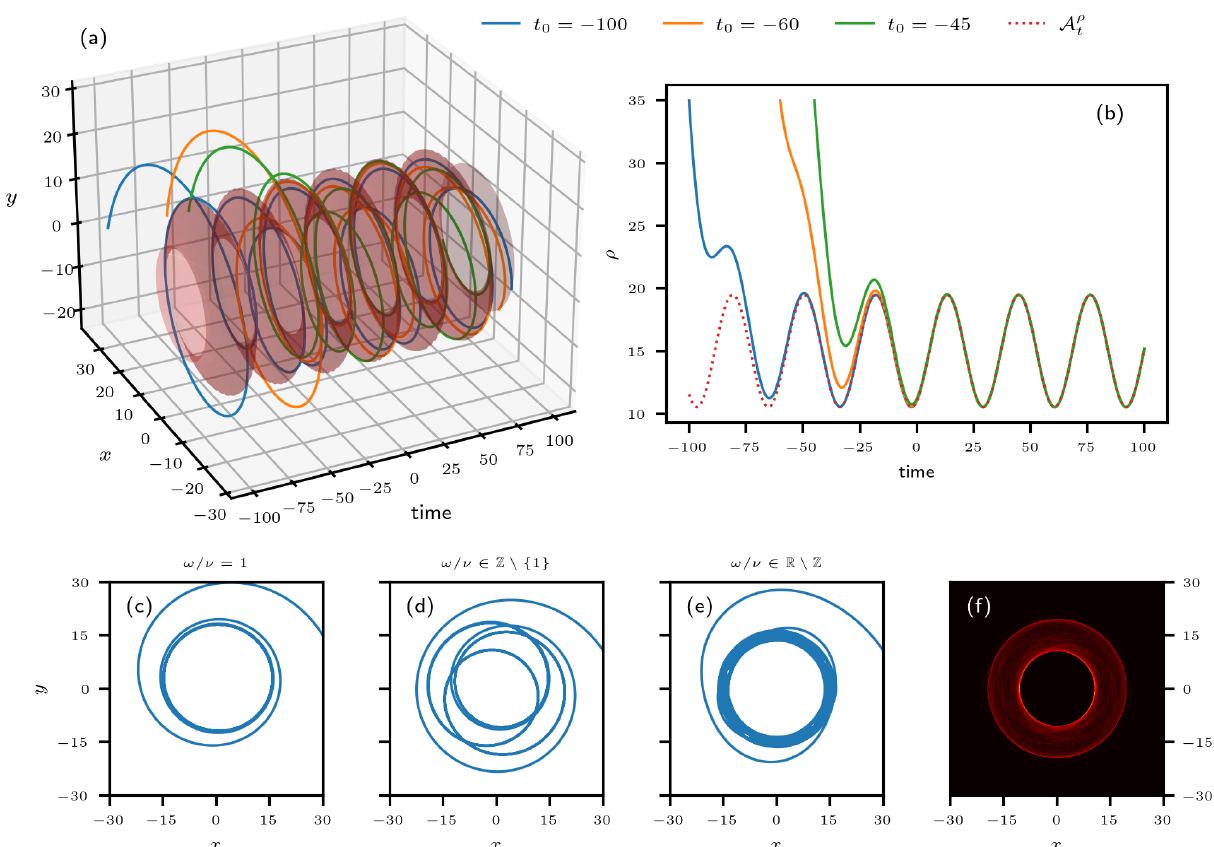
Figure 6. Trajectories and PBA of the system defined by Eqs. (15) and (16); in all the panels the parameter values are µ 0 = 15, α = 10, ν = 0 . 2, and ω = 0 . 3, unless stated otherwise. (a) Trajectories ( ρ ( t ) ,φ ( t )) of the system starting from different times in the past in the 3-D space spanned by ( x,y ) and time t ; the system’s PBA lies on the red-shaded surface. (b) Temporal evolution of the radius (solid colors) of the three trajectories shown in (a) together with its PBA (dotted red). (c–e) Trajectories integrated from t 0 = − 100 to t f = 200 for ν = 0 . 3 , 0 . 2 , 0 . 5 1 / 2 in panels (c) , (d) , and (e) , respectively. The values are chosen such that the ratio between ν and ω is ω/ν = 1, ω/ν ∈ Z \{ 1 } and ω/ν ∈ R \ Z in panels (c) to (e) . Correspondingly, in (c) the trajectory quickly converges to a circle, whose center is slightly shifted from the origin. In panel (d) a quasi-closed three-fold loop can be observed, since ω/ν = 3 / 2. In panel (e) the trajectories will densely fill the annular disk defined in the video supplement statement. (f) Heat map of numerous trajectories projected onto the ( x,y ) plane. The trajectories start at random points in state space and are integrated from t i = − 200 to t f = 200. A video of the heat map filling up as more and more trajectories with different initial conditions are added is provided in the video supplement. The heat map shown here is a snapshot of the video taken at time t = 0 . 20; see details in the video